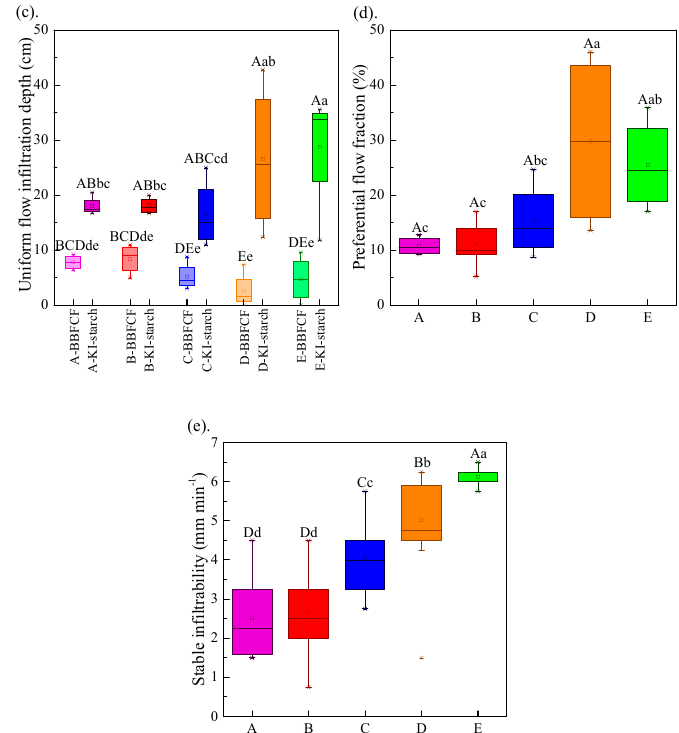
Figure 6. Box plots (in quartiles) showing: ( a ) total dye coverage, ( b ) maximum infiltration depth, ( c ) uniform flow infiltration depth, ( d ) preferential flow fraction, and ( e ) stable infiltrability extracted from stained images for experimental plots (A) bottom–, (B) lower–, (C) mid–, (D) upper–, and (E) top–slope. The number of samples for each box plot is five, and the band and square inside the boxes are the median and mean, respectively. Capital letters above the box indicate highly significant differences ( p < 0.01) between the corresponding variables among experimental plots A–E under 2 different treatments (10 groups for the preferential flow index in Figure 4a–c), whereas lowercase letters indicate significant differences with p < 0.05.